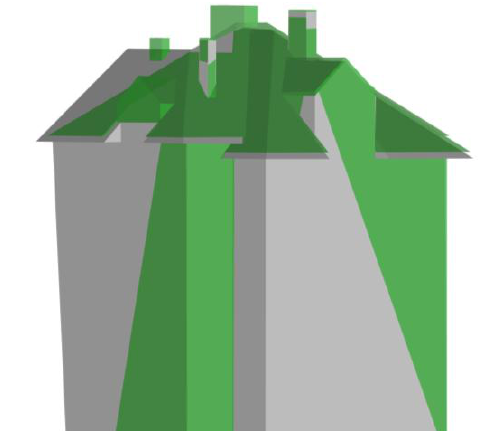
Figure 4. Vector model of the same building created from airborne (green) and terrestrial (grey) scanning data